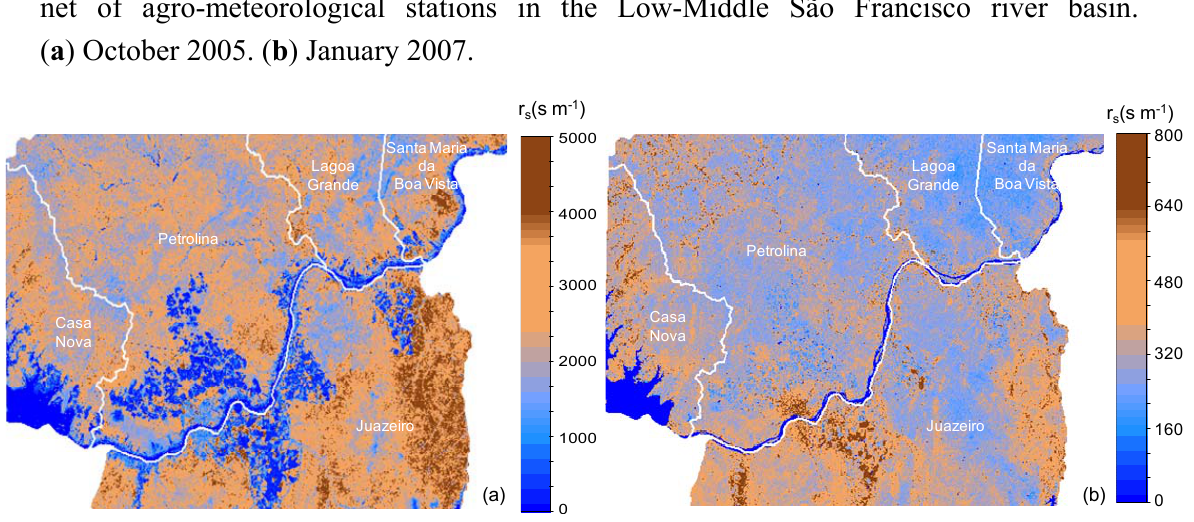
net of agro-meteorological stations in the Low-Middle São Francisco river